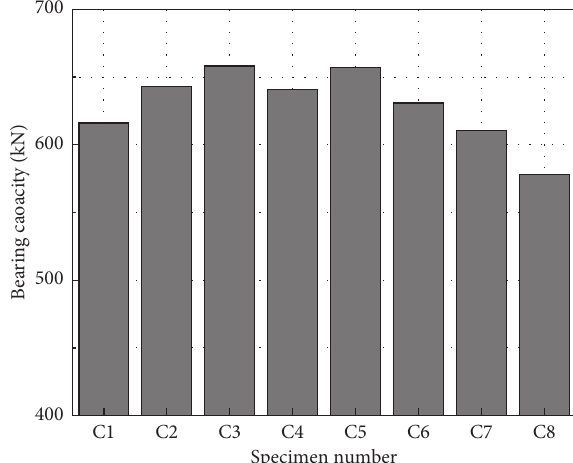
Figure 5: Comparison of bearing capacity of tested specimens.